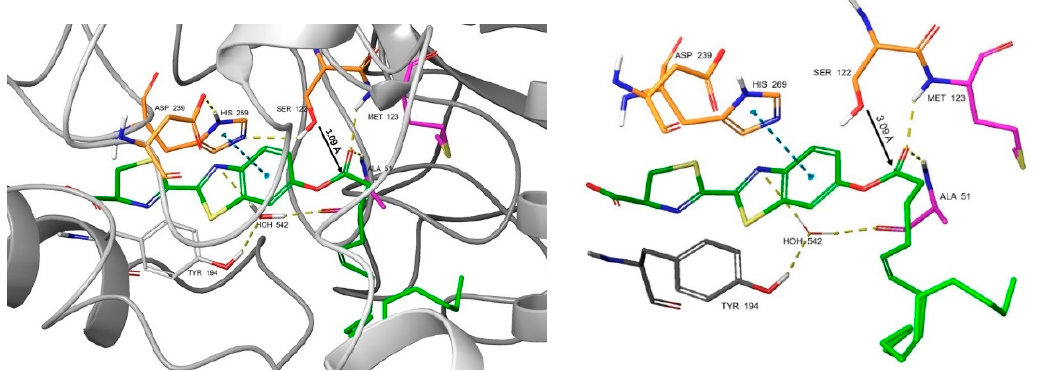
Figure 7. Top scoring docking pose of compound ArLuc- 1 (green stick) into the MAGL binding site. Residues are numbered according to the PDB crystal (5ZUN) convention. The triad catalytic residues are shown in orange sticks, those forming the oxyanion hole in magenta sticks. H-bonds and the π – π stacking interaction are represented with yellow and blue dashed lines, respectively. The black arrow represents the distance between the oxygen atom of the hydroxyl group of Ser122 and the carbon of the carbonyl group of ArLuc- 1 .